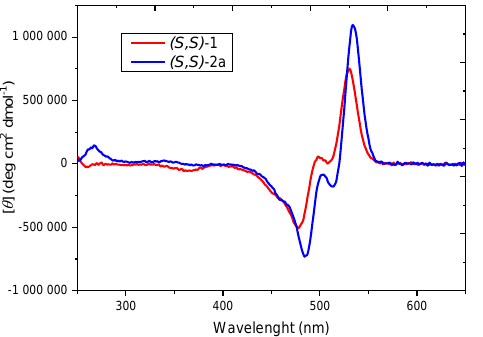
Figure 2. Circular dichroism spectra of ( S , S )- 1 (red) and ( S , S )- 2a (blue) in chloroform (4 × 10 − 6